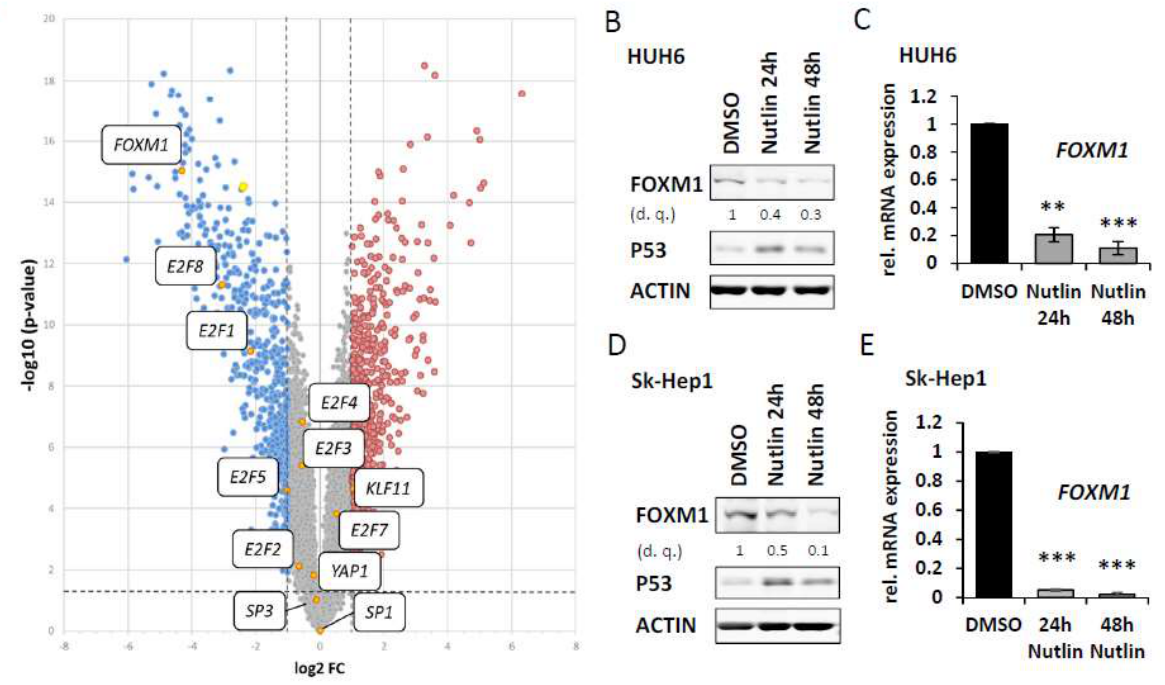
Figure 5. FOXM1 is repressed after P53 induction. Research for transcription factors involved in P53/P21-dependent repression of HELLS reveals FOXM1 : ( A ) Volcano plot as introduced in Figure 3. Transcription factors previously described as regulators/interactors of HELLS are highlighted in orange. FOXM1 as the most strikingly repressed transcription factor with potential involvement in HELLS regulation and high functional relevance in HCC ( B ) HUH6 cells were treated with DMSO or Nutlin-3a for 24 h or 48 h. Densitometric quantification (d. q.) of FOXM1 normalized to